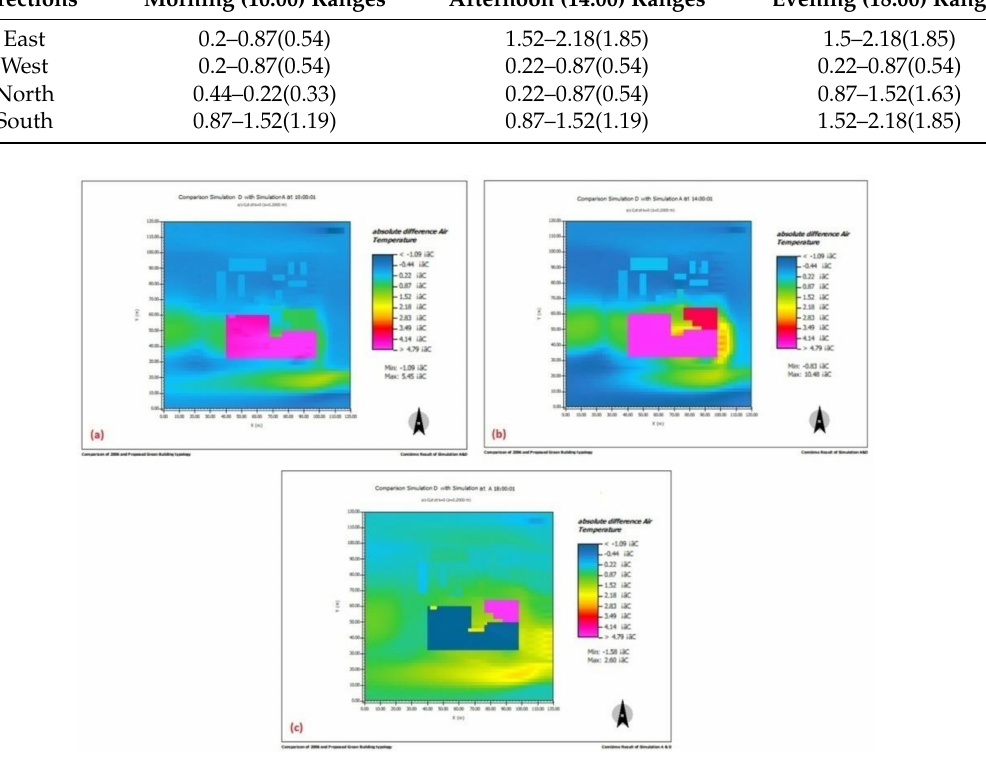
Figure 14. Comparison of differences in T air in the( a ) morning; ( b ) afternoon; and ( c )